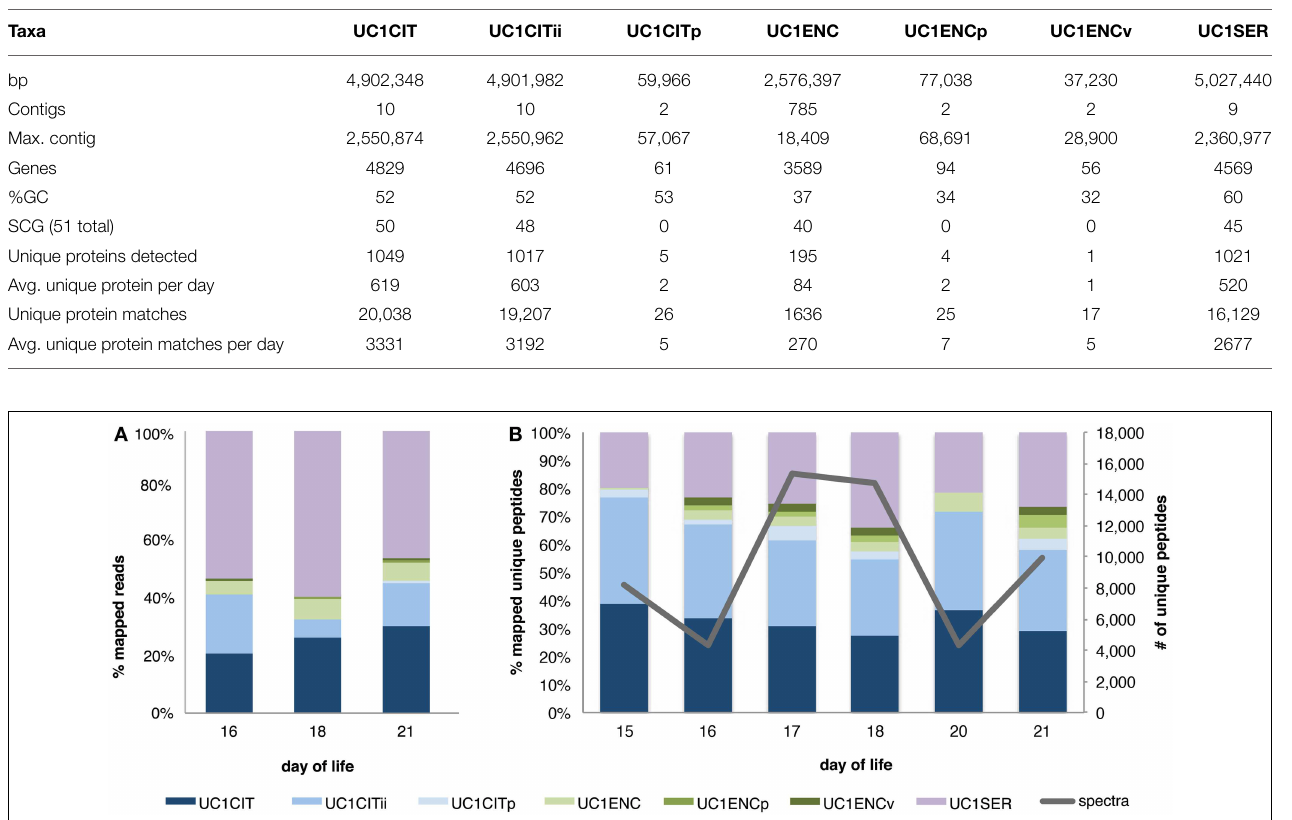
TABLE 1 | Genome and proteomics summary.